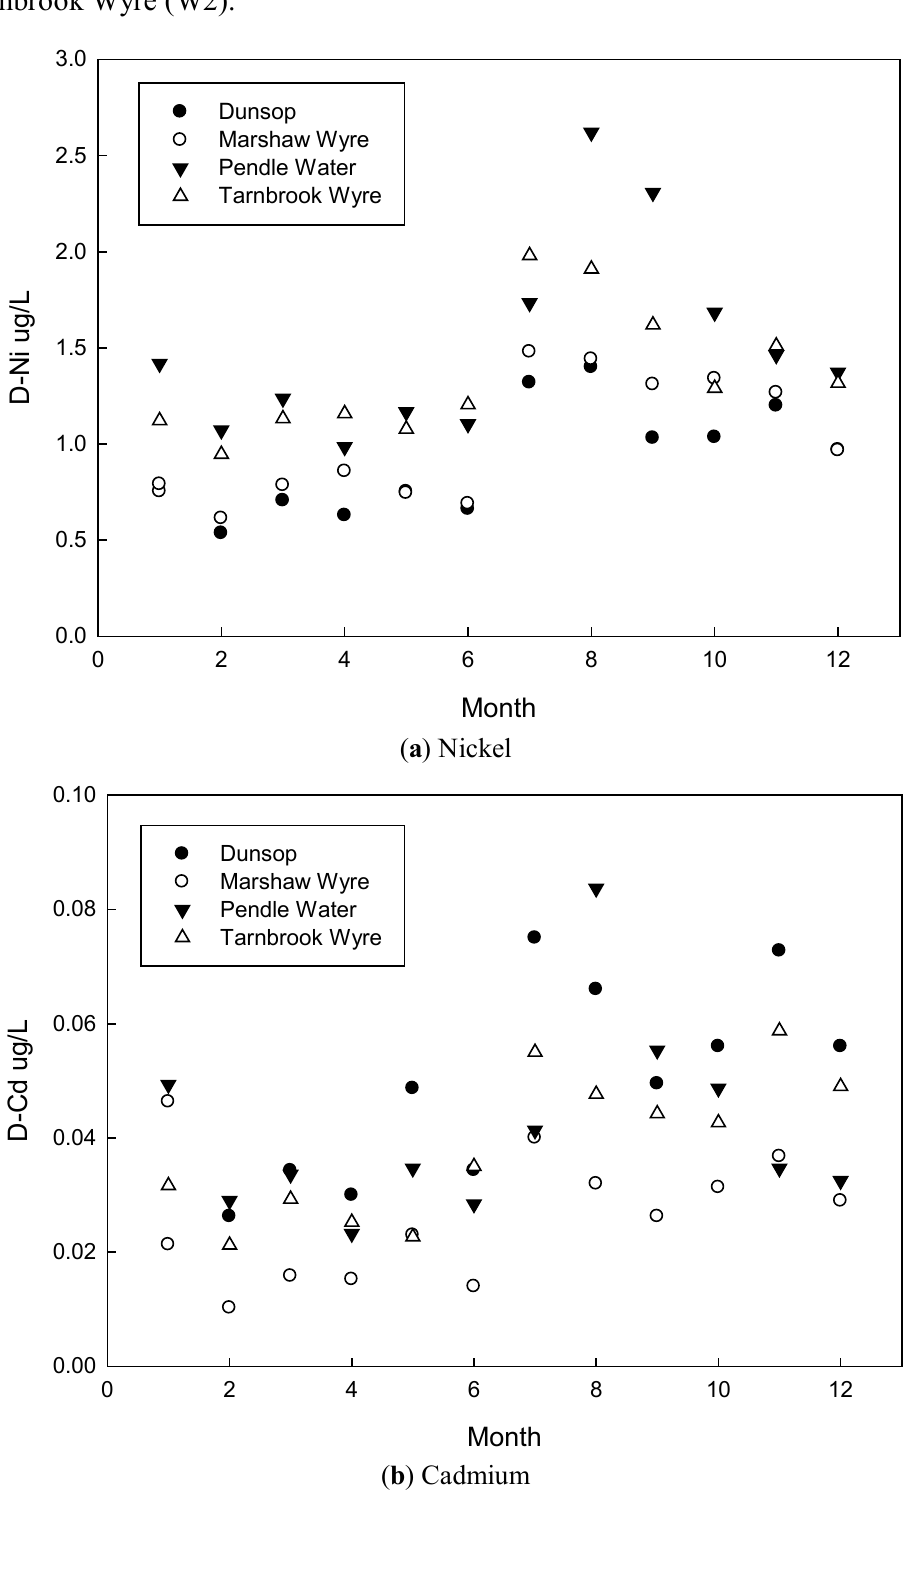
Figure 2. Monthly trends in toxic metals concentrations (a) Ni (b) Cd (c) Pb and (d) discharge for clean sites of the Dunsop (R1), Marshaw Wyre (W1), Pendle Water (C1) and Tarnbrook Wyre